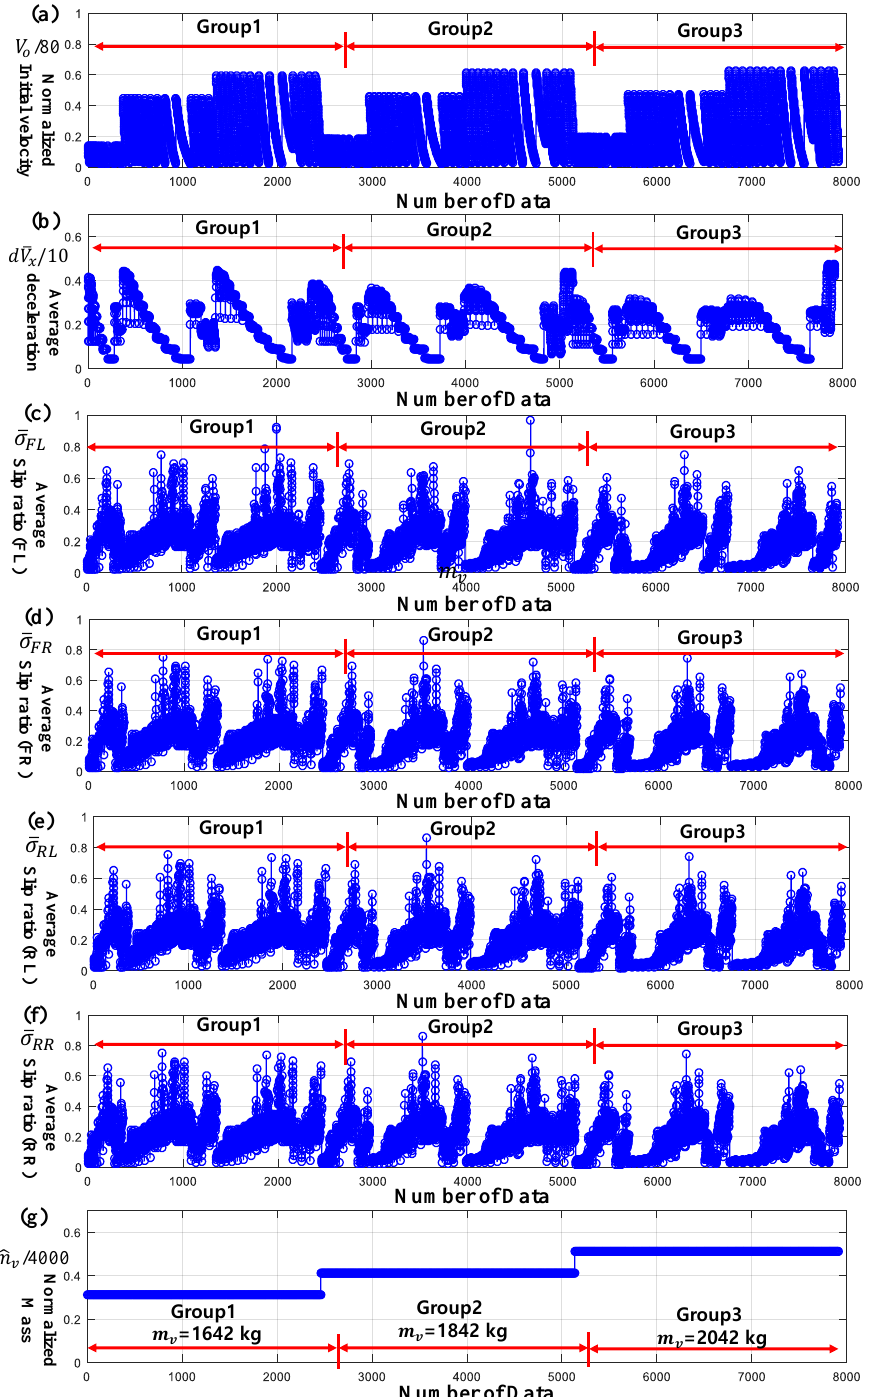
Figure 8. Input training data set ( a ) Normalized initial velocity at the braking ( V 0 ), ( b ) normalized average deceleration ( dV aver ), ( c ) average front-left wheel slip ratio (FL), ( d ) average front-right wheel slip ratio (FR), ( e ) average rear-left wheel slip ratio (RL), ( f ) average rear-right wheel slip ratio (RR), and ( g ) normalized vehicle mass.